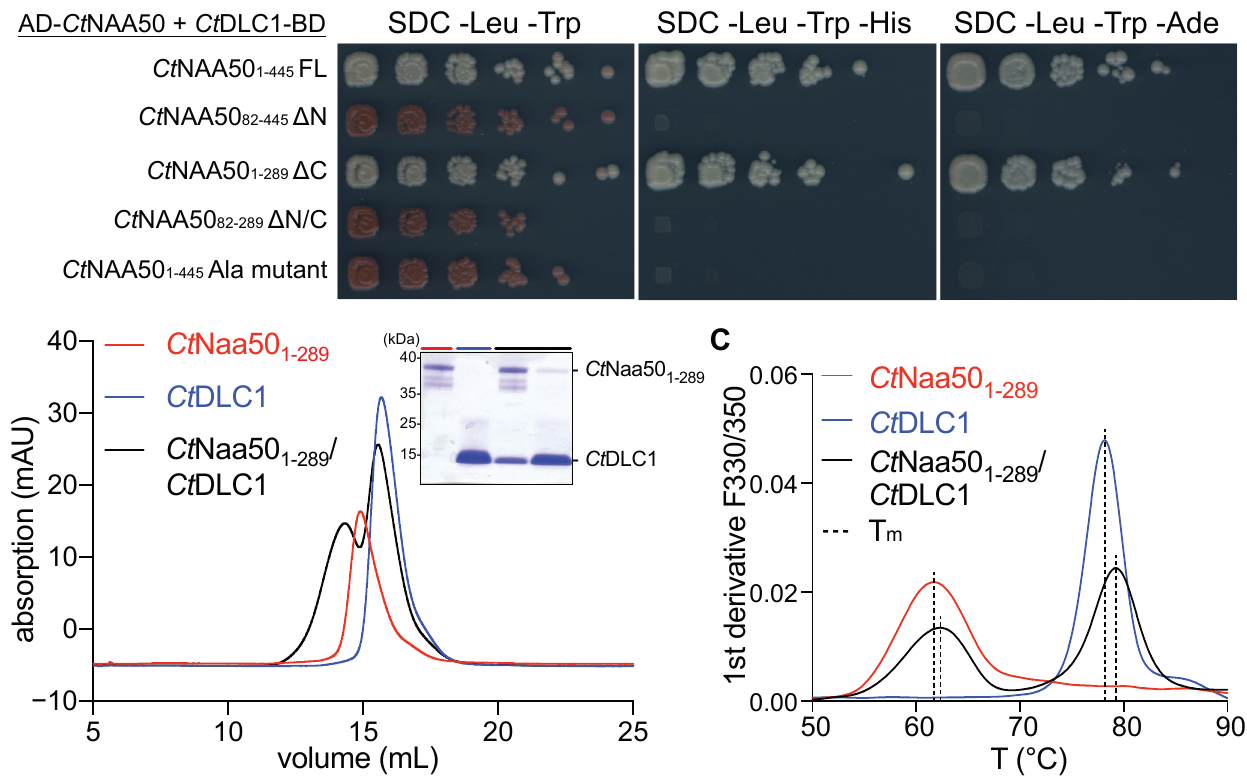
Figure 9. Ct Naa50 binds to Ct DLC1 with its N-terminal RATQT motif. ( A ) Ct NAA50 full-length (FL) interacted with Ct DLC1 in a yeast two-hybrid assay. Naa50 truncation variants lacking the N-terminus ( ∆ N or ∆ N/C) and a poly-Ala mutant (DLC1 binding motif 34 RATQT 38 mutated to 34 AAAAA 38 ) did not interact with Ct DLC1. Coding sequences were fused to Gal4 activation (AD) or binding domains (BD). Growth on SDC -Leu/-Trp indicated successful transformation. ( B ) Ct Naa50 1-289 incubated with Ct DLC1 led to an elution peak shift on an analytical size-exclusion column. Peak fractions are visualized by SDS-PAGE with Coomassie stain. ( C ) Ct Naa50 1-289 and Ct DLC1 did not significantly differ in melting temperatures T m when tested alone or in